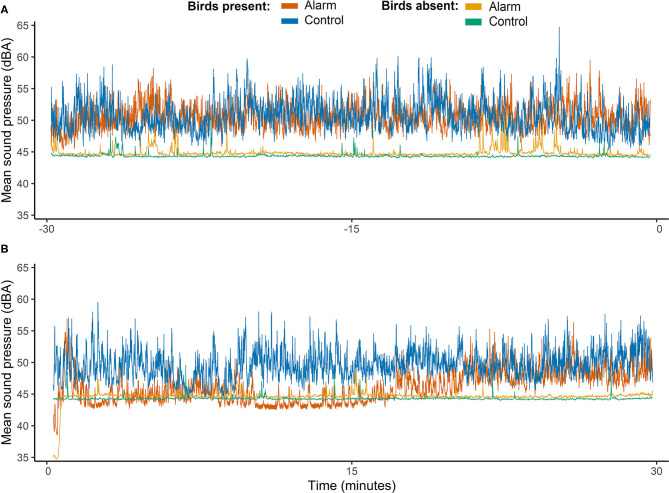
Time series of mean sound pressures (dBA) measured on each of the test days (alarm and control) and represented for days when birds were present and absent of the experimental room. Time axis shows a timescale in minutes of intervals before and after the stimulus interval (alarm and control). Negative numbers correspond to the minutes before the stimulus started (A) and positive values correspond to minutes after the stimulus interval finished (B).